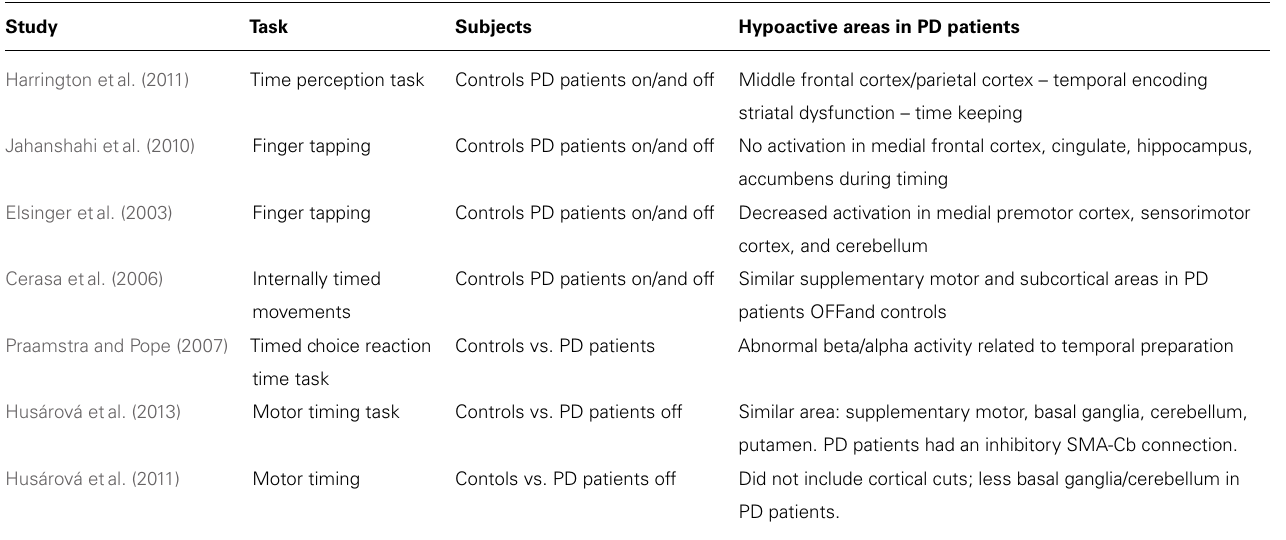
putamen. PD patients had an inhibitory SMA-Cb connection. Did not include cortical cuts; less basal ganglia/cerebellum in PD